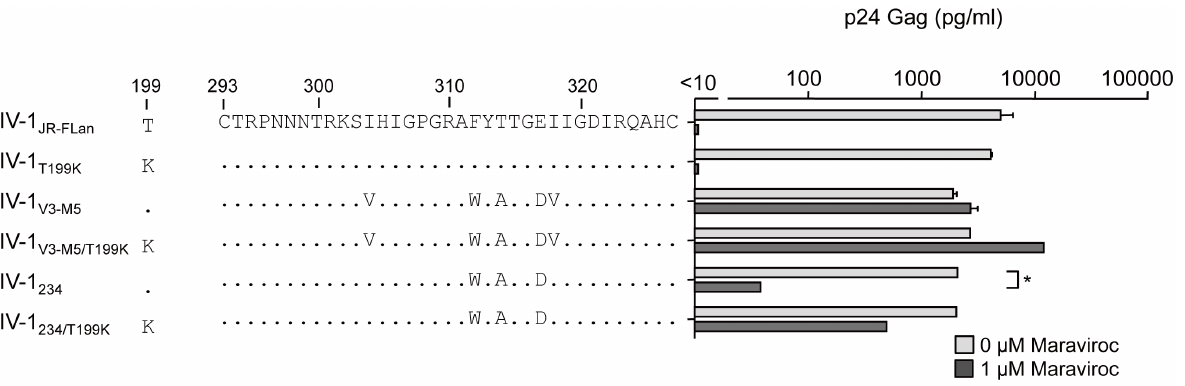
Figure 4. The effect of 1 m M of maraviroc on p24 Gag production in HIV-1 JR-FLan , HIV-1 T199K , HIV-1 V3-M5 , HIV-1 V3-M5/T199K , HIV-1 234 , and HIV-1 234/T199K . PM1/CCR5 cells (1 6 10 5 ) were infected with 10 ng p24 Gag for 3 h in the presence or absence of 1 m M maraviroc. On day 6 after infection, the amount of Gag in the supernatant was measured using HIV-1 p24 ELISA. The analysis was repeated three times; the error bars represent the S.D. of three replicates from one representative experiment. **, p , 0.01. Statistical significant difference was calculated by t test.